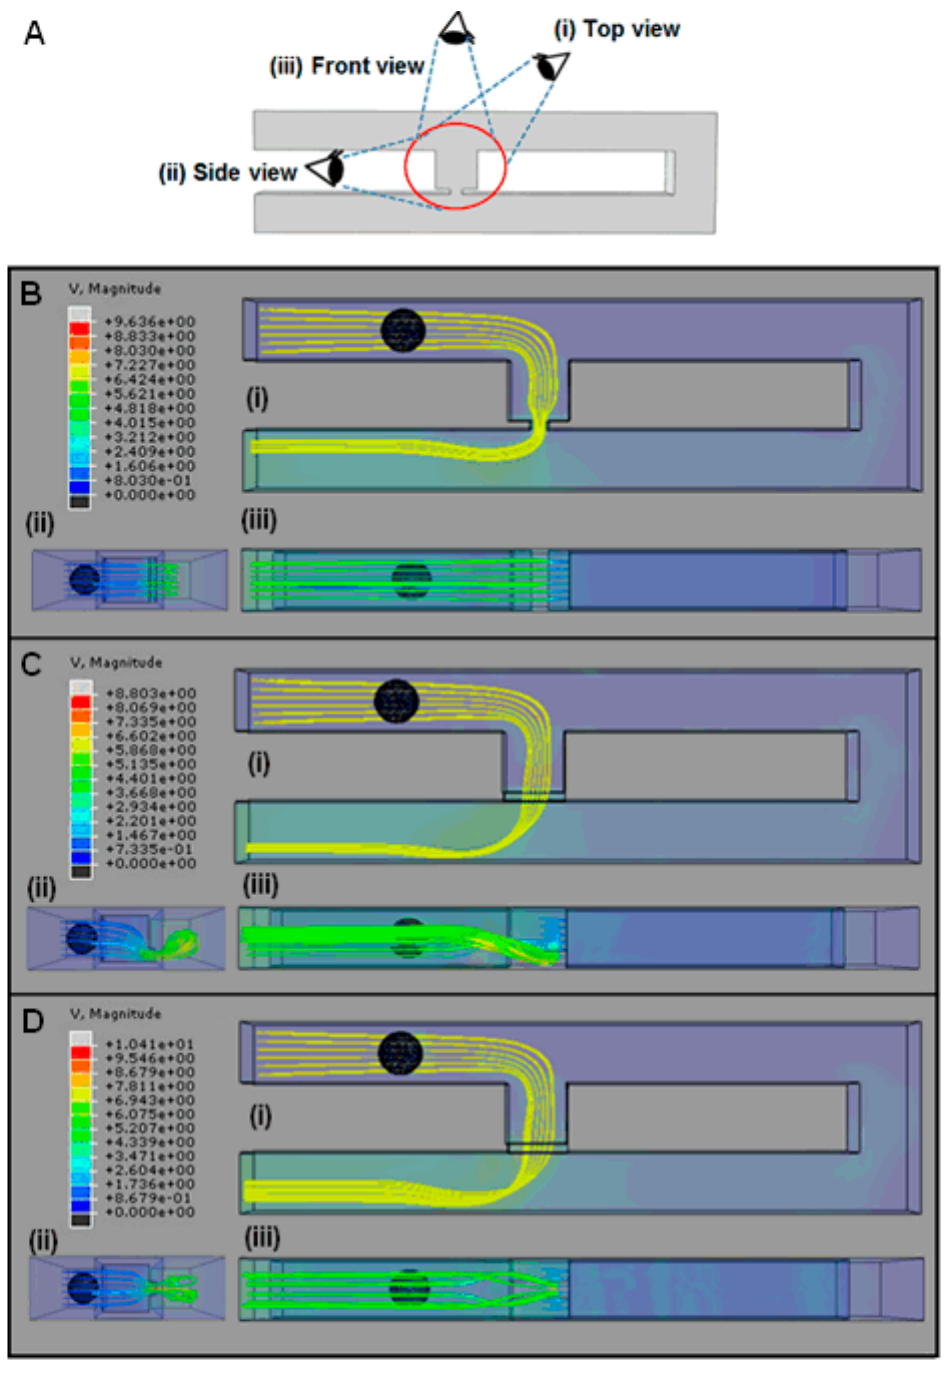
Figure 9. Streamline velocity for three different cell trapping models with the same trap hole size (2 μ m, 7 μ m, and 7 μ m of W , L , and H , respectively) for an Rh Main / Rh Trap ratio of 3.5 at three different positions: ( A ) model A; ( B ) model B; and ( C ) model C. ( Left ) side view; ( right ) top view ( top ) and front view ( bottom ) of the model. V represents the fluid’s velocity in μ ms − 1 .